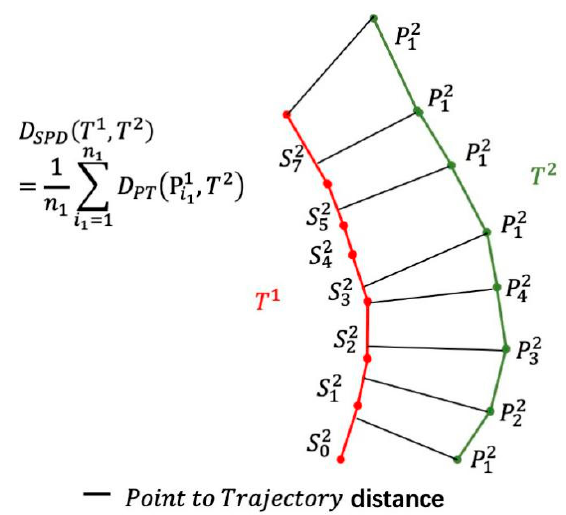
1 to the trajectory T 2